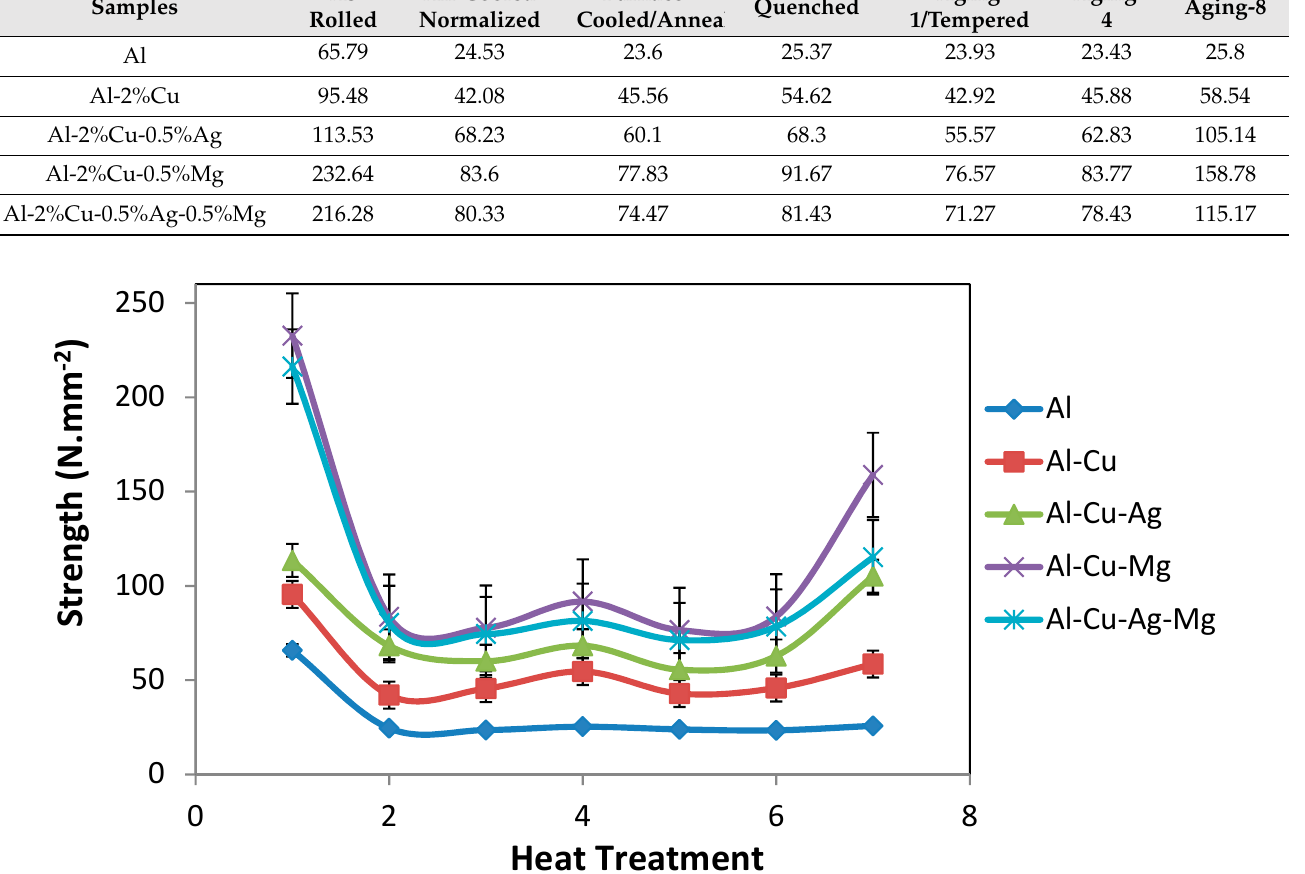
Figure 6. Variation of Strength (N/mm 2 ) with heat treatment of different alloys. It has been seen that the as-cast (as-rolled) specimens have the greatest yield strengths and ultimate tensile strength, then the age hardened specimens, quenched specimens, normalized and, in the last place, the annealed specimens. The presence of dislocations within the crystal structure due to the hot rolling process in the as-cast (as-rolled) structure allow it to get the highest strength and hardness among all of the samples, due to the brittleness effect gained by generating dislocations into the aluminum alloy. The variation in grain size after the heat treatment process for the remaining samples represents the main reason for low strength and hardness trend observed. That is exactly what Kenji et al. [28] concluded from their research work, which confirm that the grain refinement and the solid solution can contribute significantly to the aluminum–magnesium alloy hardening. Furthermore, it has been well reported in may previous researches that the large grained materials have less grain boundaries, and vice versa; fine grained materials have much more grain boundaries, and are thus stronger and harder than the large grained the age hardened samples over than quenched, normalized, and annealed samples is the dislocation motion during deformation, since it has more grain boundaries